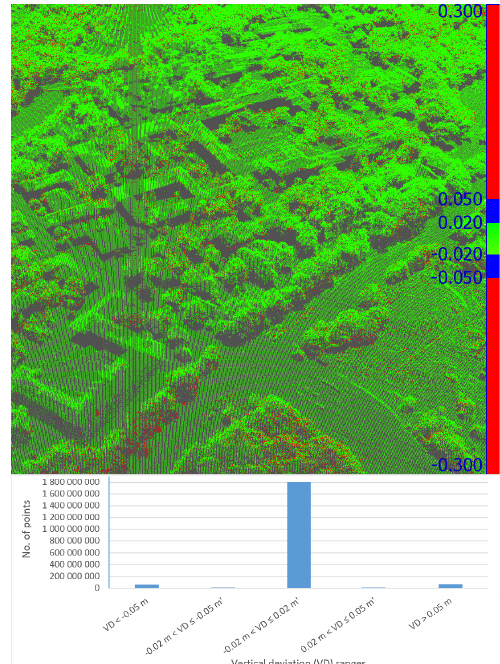
Figure 7. Visualization of distribution and histogram of the vertical deviations between computed DEM in Metashape and LiDAR point cloud